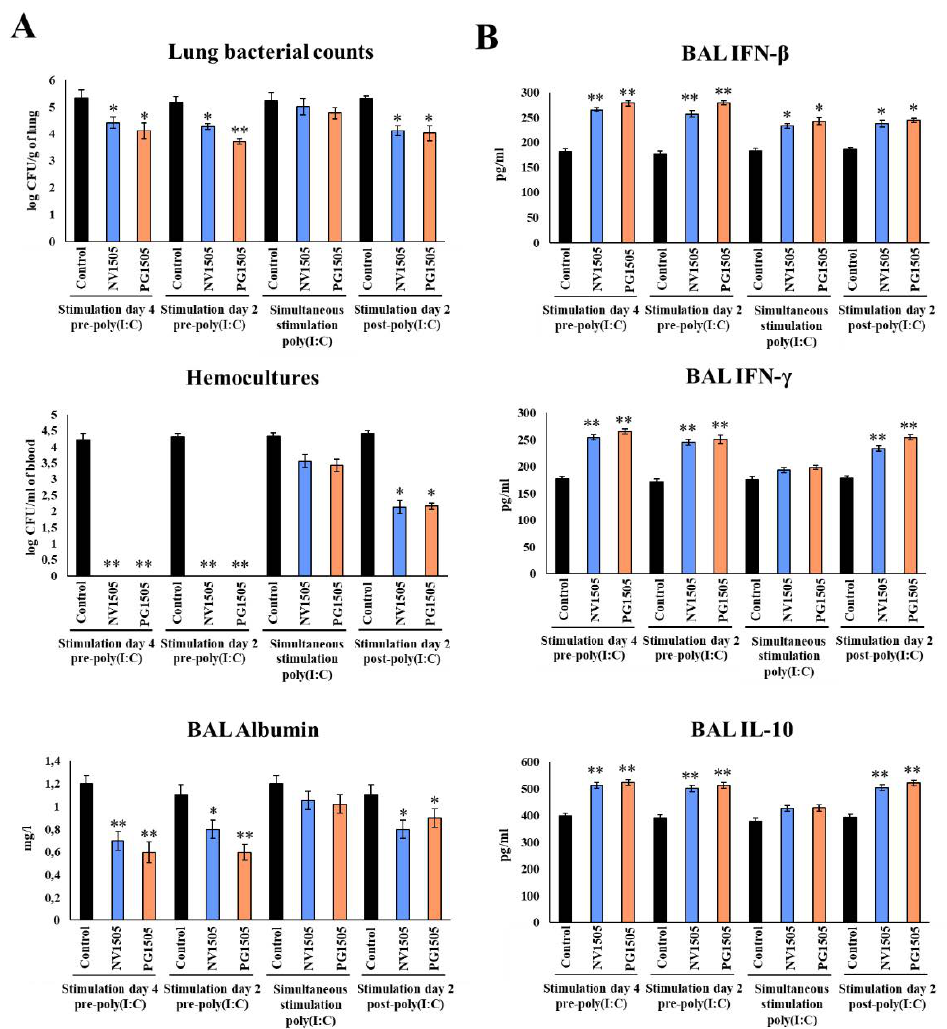
Figure 7. Window of opportunity to improve the protection against secondary pneumococcal pneu- monia with NV1505 or PG1505 treatments. Infant mice were nasally treated with NV1505 or PG1505 2 and 4 days before, concomitantly or 2 days after the administration of poly(I:C). In all groups, S. pneumoniae infection was induced on day 5 after the last poly(I:C) administration. ( A ) Lung bacterial cell counts, hemocultures and albumin concentrations in bronchoalveolar lavages (BAL) as well as ( B ) the levels of interferon (IFN)- β , IFN- γ and interleukin (IL)-10 BAL were determined on day 2 post- pneumococcal challenge. The results represent data from three independent experiments. Asterisks indicate significant differences between treated and control groups; * ( p < 0.05) and ** ( p < 0.01). 3.6. NV1505 and PG1505 Protect Infant Mice from Secondary Pneumococcal Pneumonia